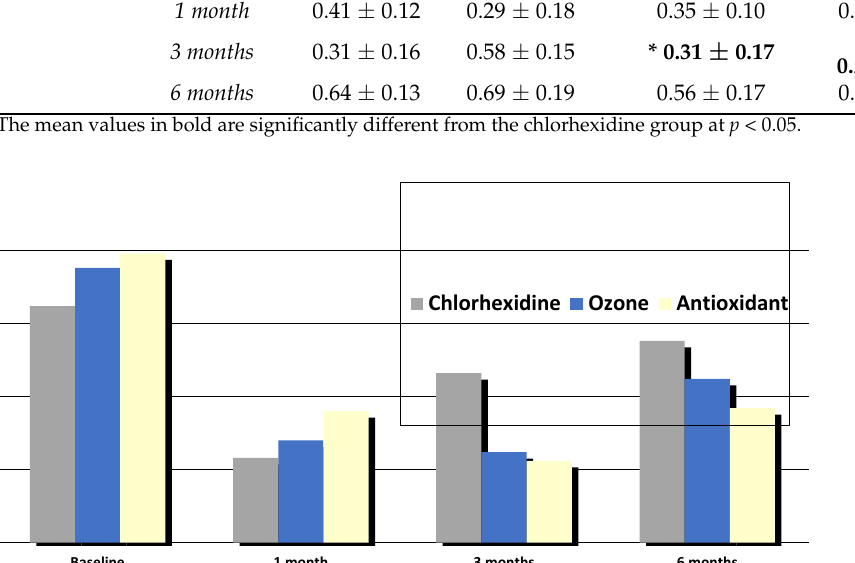
Table 3. The outcome measures for reactive oxygen metabolites (dROMs, PAT, SAT) and glycated hemoglobin (HbA1c) were measured at baseline and at one, three, and six months. Variable